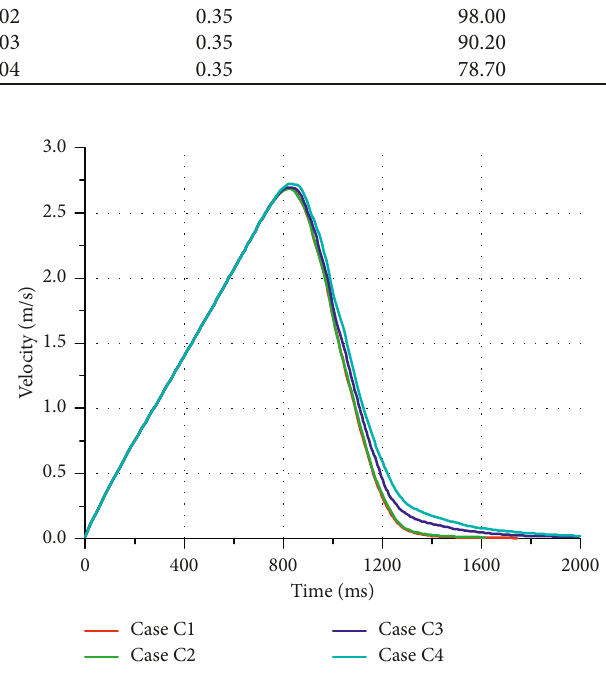
Figure 14: Time history of the granular flow velocity when RNB with different mesh sizes was